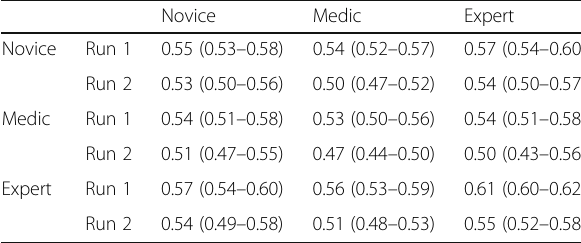
Table 1 Means (95% CI) for each between-group comparison and run through for ScanMatch similarity